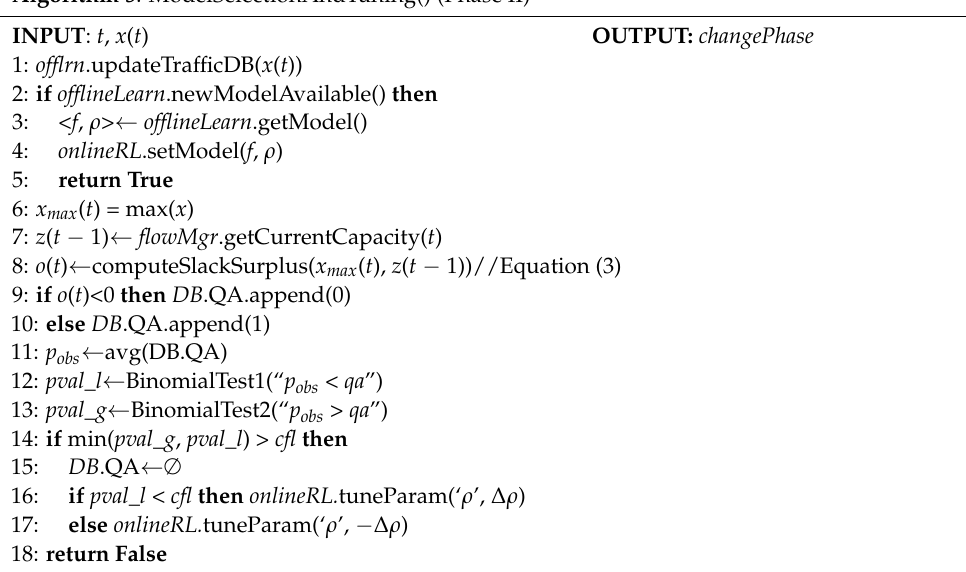
Algorithm 5 . ModelSelectionAndTuning() (Phase II)